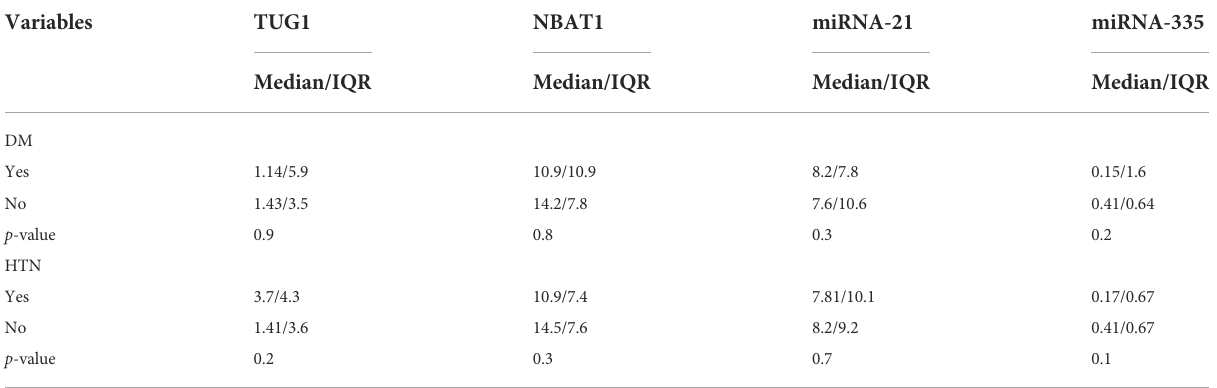
TABLE 4 Comparisons of biomarkers in different comorbidities among